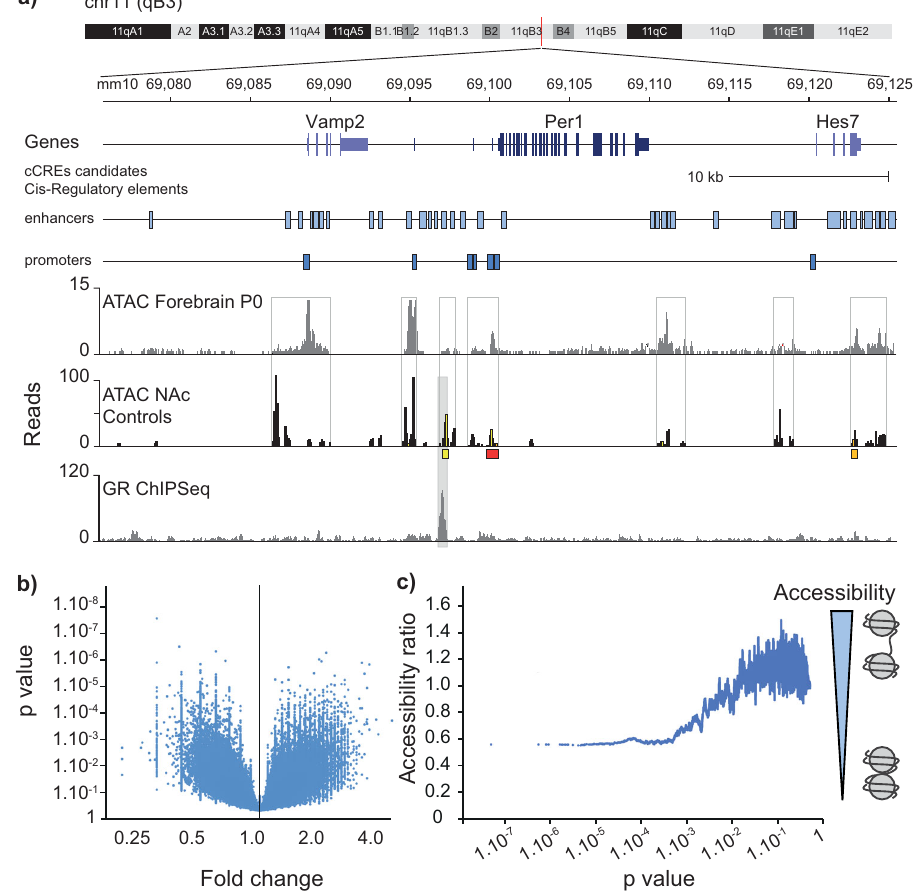
Fig. 7 Genome accessibility. Accessibility changes in the absence of BRG1. a Within Per1 gene locus, regions of accessible DNA in adult NAc